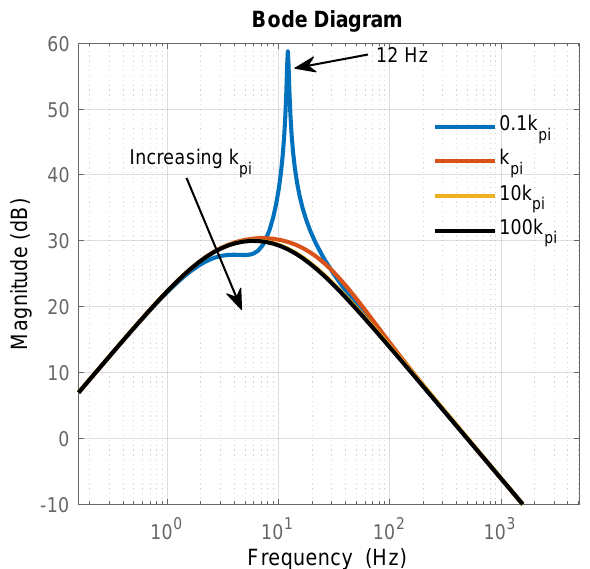
Figure 16. Sensitivity of DC input impedance to k pi in increasing order of 0.1 × , 1 × , 10 × , and 100 × k pi (base case).